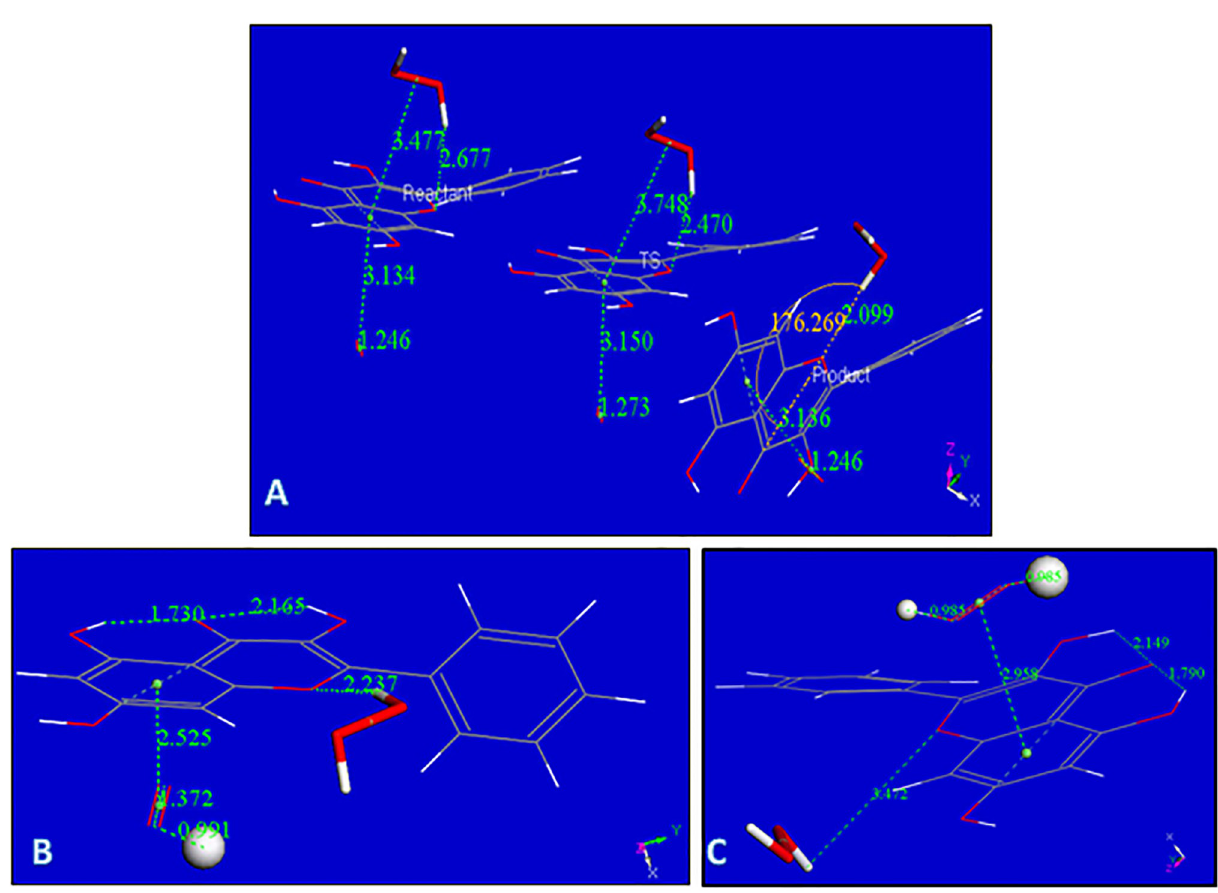
Fig 8. A: Rearrangement of H 2 O 2 moiety as described by the Transition State search (TS): left, reagent; center TS; right, product, are displayed; B: From the product of Fig 8A proton is captured by the O 2 moiety, total charge is 1; C: From Fig 8B an additional proton, small ball size, is captured by the HO 2 moiety forming H 2 O 2 , while the other H 2 O 2 located in the polyphenol plane, detaches from galangin, 3.472 Å . Total charge of this radical species is 2.